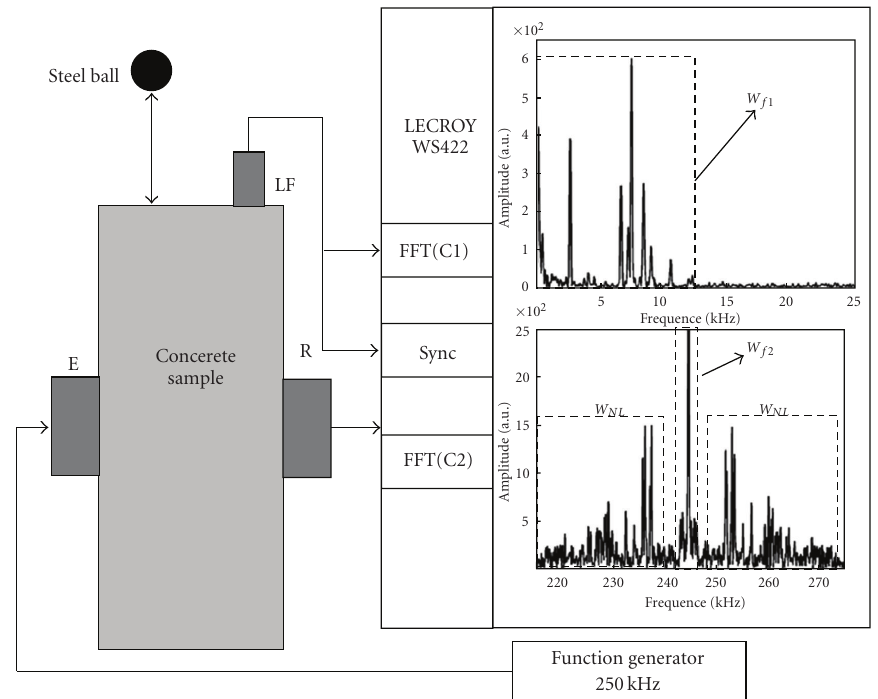
Figure 6: Experimenatl setup. FFT (C1) and FFT (C2) are respectively the typical frequency spectrums of LF and HF obtained in experiments. FFT (C2) illustrates the interaction of HF with LF.